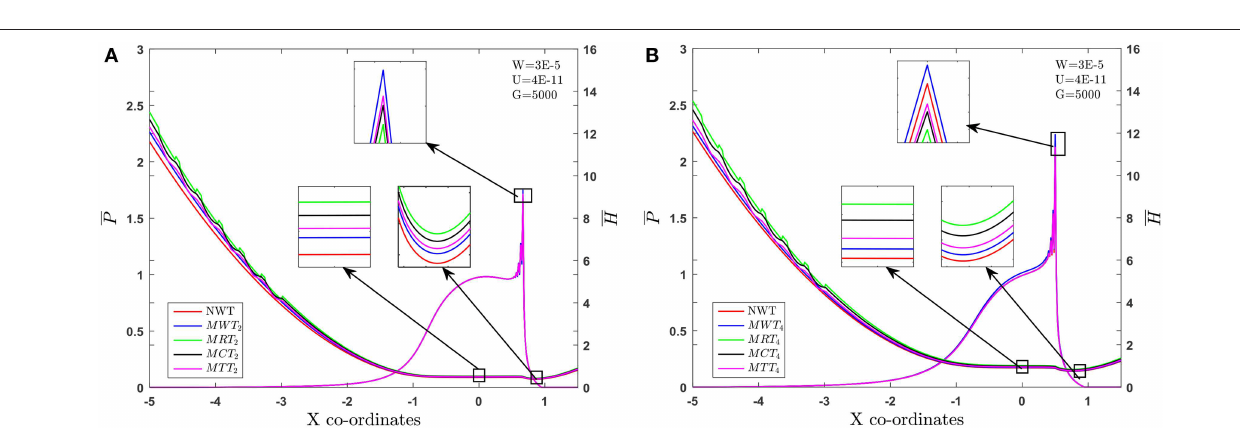
FIGURE 8 | Combined influence of Hm (A) 2, (B) 4, and micro textures shapes in inlet zone U = 4 E − 11.